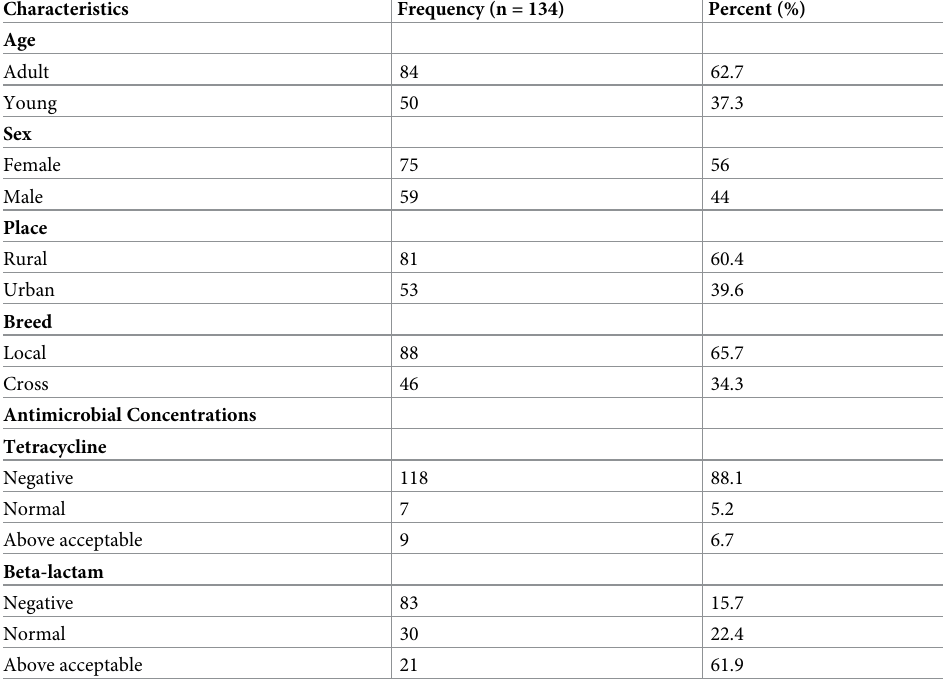
Table 1. Characteristics of cattle carcass